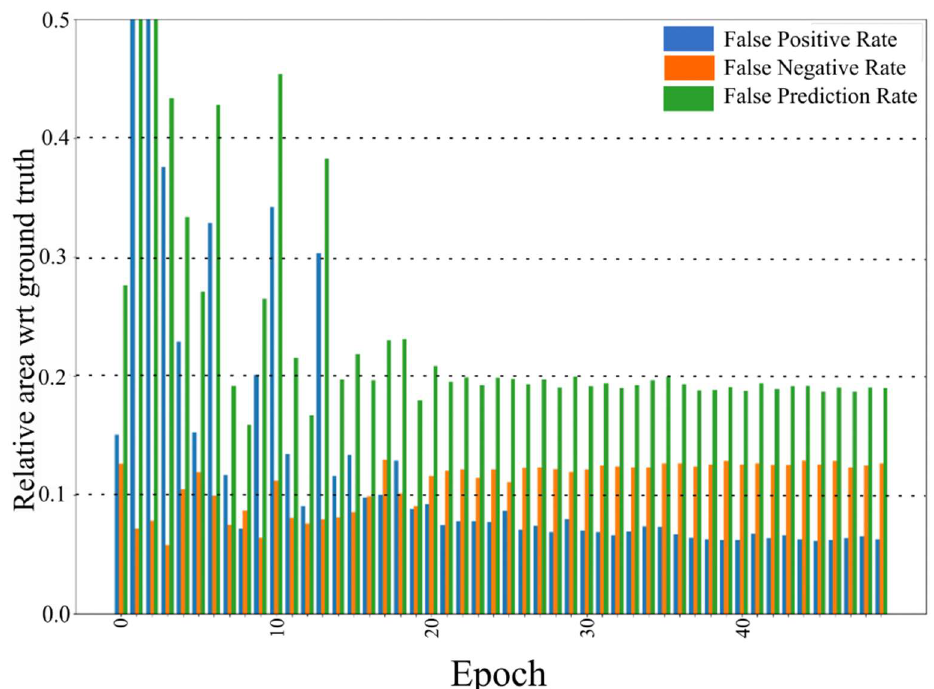
Figure 7. Comparison of all 50 checkpoints to the corrected shapefile of the 2013 (July 14) test scene. False positive rate = a lake polygon was predicted where no lake exists. False negative rate = no lake polygon was predicted where a lake exists. False prediction rate = sum of false positive rate and false negative rate. (‘wrt’ = with respect to).